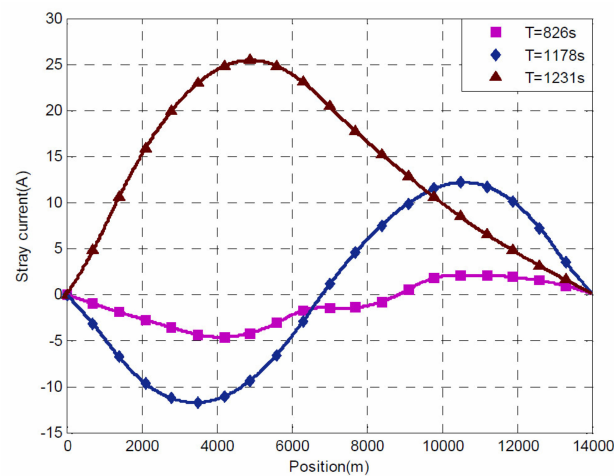
Figure 6. Example of stray current vs. position along the track. Reproduced from